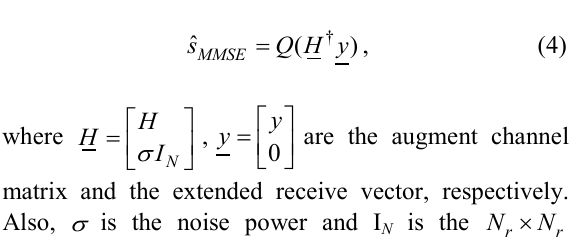
Fig. 1. MIMO system